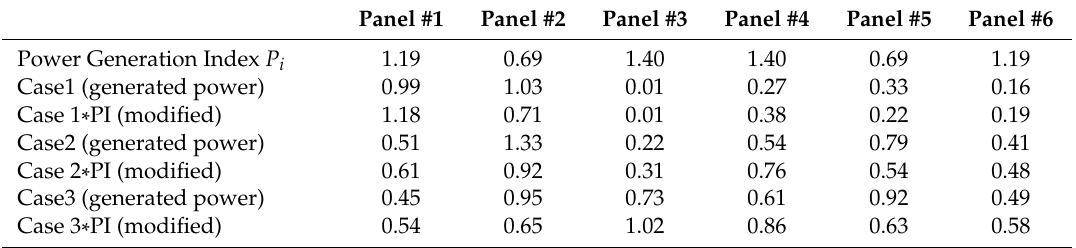
Table 5. Application of power generation index for detecting damage with MEH.